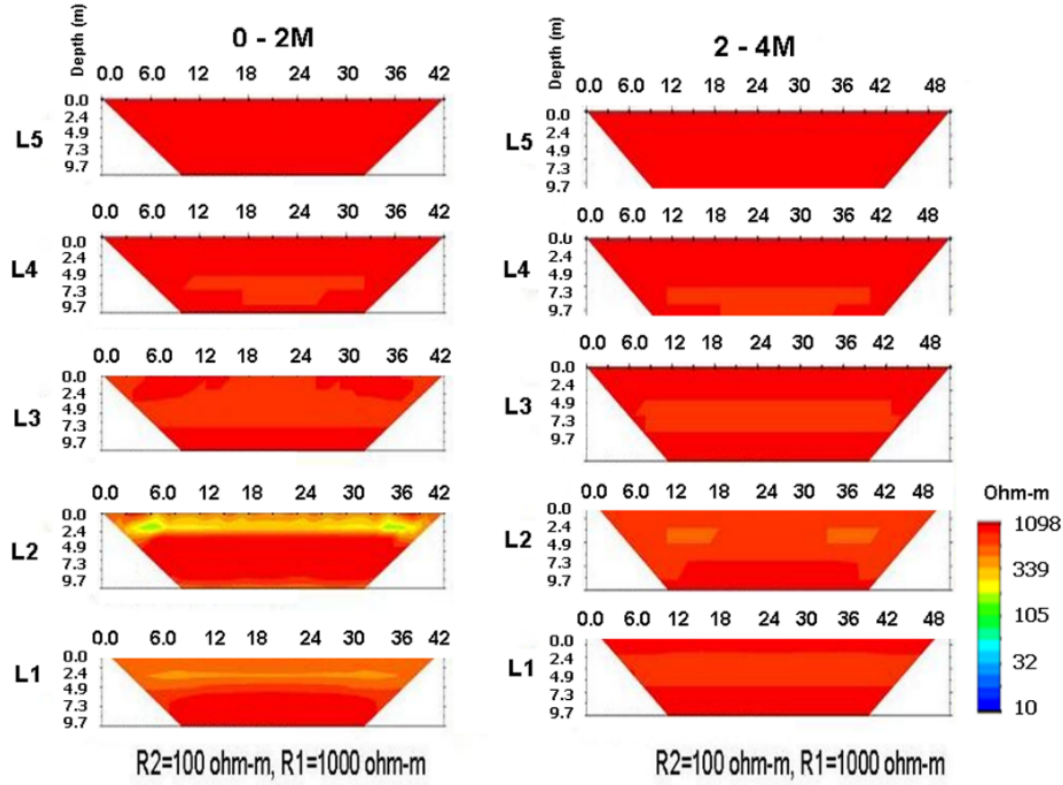
Figure 7. The influence of the pipeline embedding depth in the pipeline stratum model on the 3D effect.